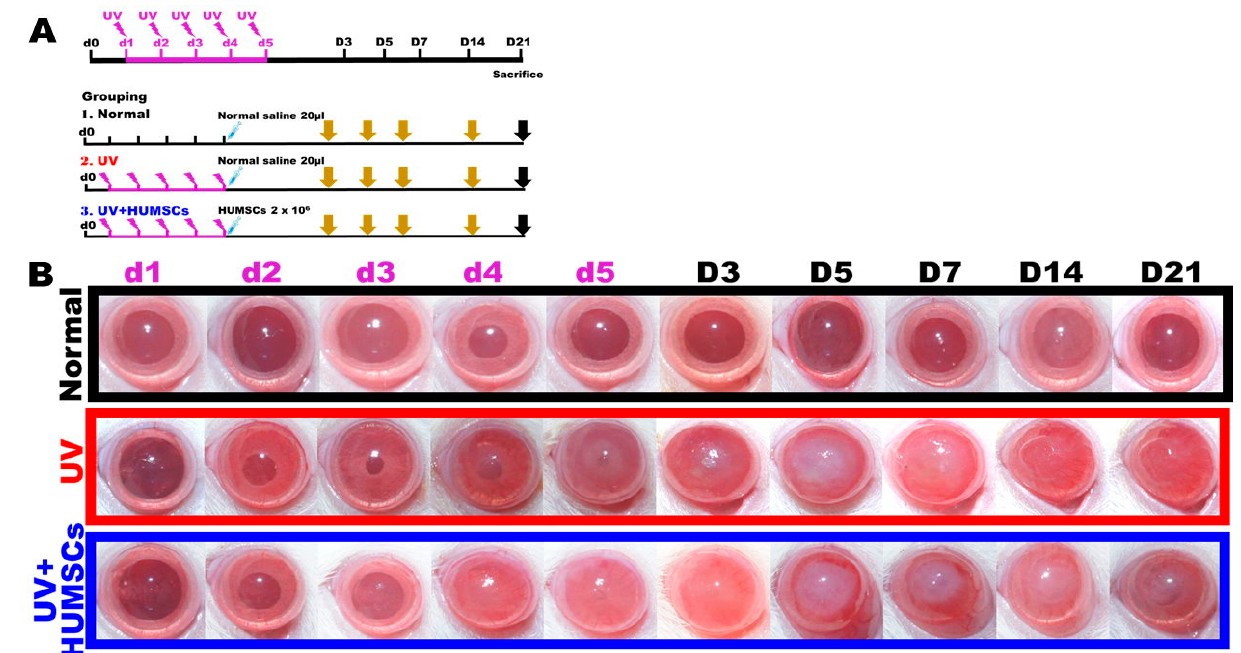
Figure 1. Experimental protocol and effects of UV irradiation and HUMSC treatment. The experimental flowchart for inducing photokeratitis, the transplantation of the HUMSCs, and the time course of the experiments in this study. The Normal group was administered a subconjunctival injection of 20 µL of normal saline on day 5. The daily UV was performed on day 1 through day 5. The experimental animals of the UV group served as UV controls exposed to UV light and were treated with subconjunctival injection of 20 µL of normal saline. The experimental animals of the UV + HUMSC group were exposed to UV irradiation and administered a subconjunctival injection of HUMSCs on day 5 ( A ). The corneas of the control rats were transparent and intact. UV radiation caused severe injury to the cornea, including apparent decomposed smoothness and opacity in the UV group. In contrast, significant enhancement of corneal organization and transparency were observed in the UV + HUMSC group compared with the corneal damage observed in the UV-treated animals on day 21 after UV irradiation ( B ).